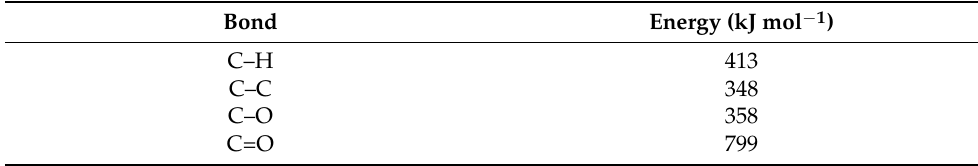
Table 1. The energies involved in the PCL chains [24].